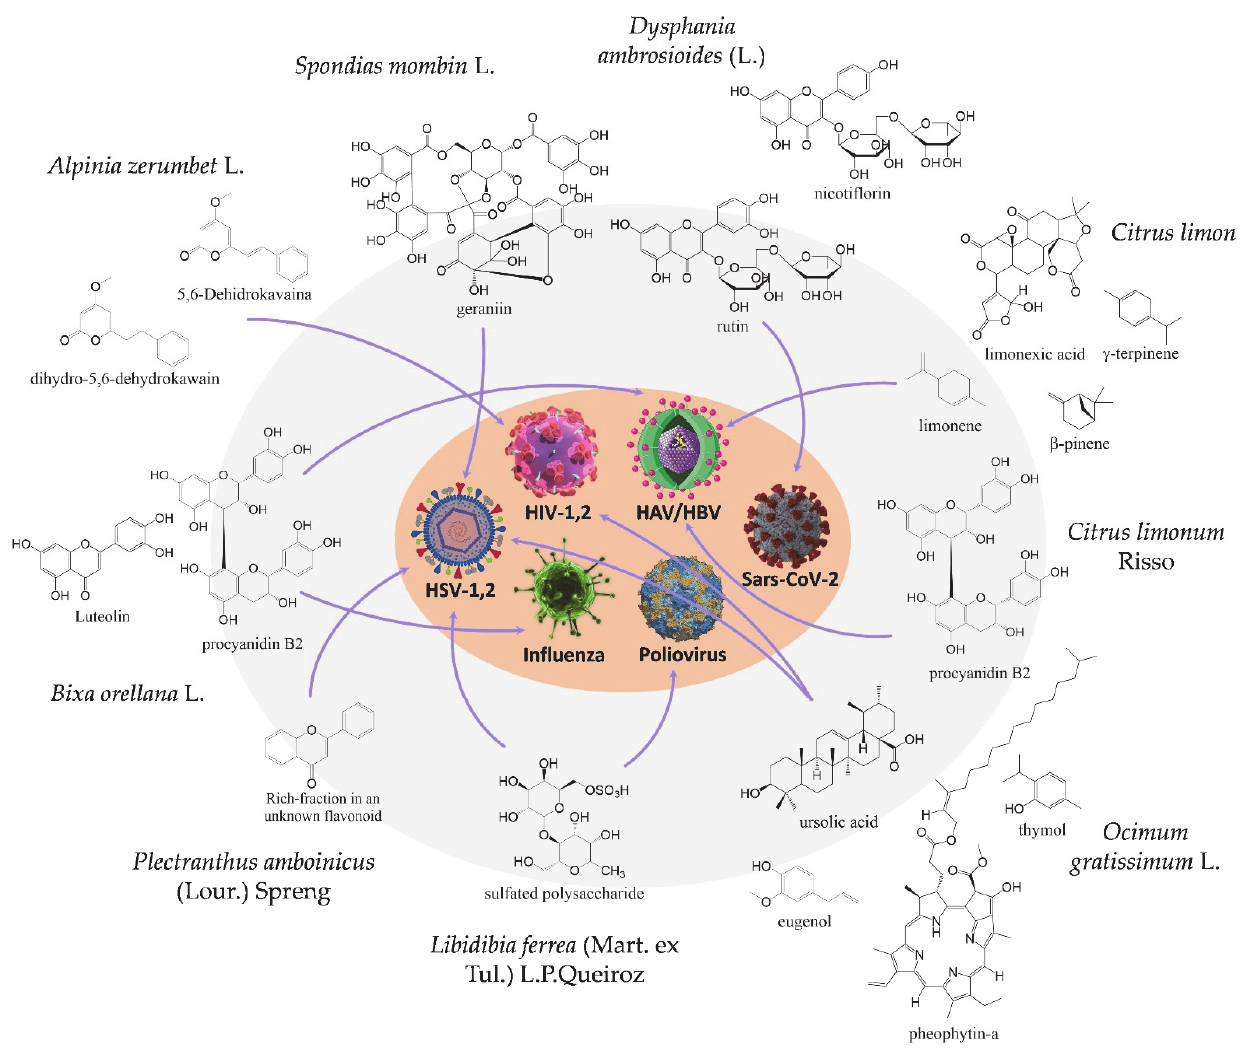
Figure 2. Compounds that, until this review, have already been reported to have antiviral activity for each species. Therefore, all compounds are referenced in Table 2, except Plectranthus amboinicus, from which a rich fraction of an unknown flavonoid was reported. Table 1. The main plants cited to treat viral diseases in Maraj ó